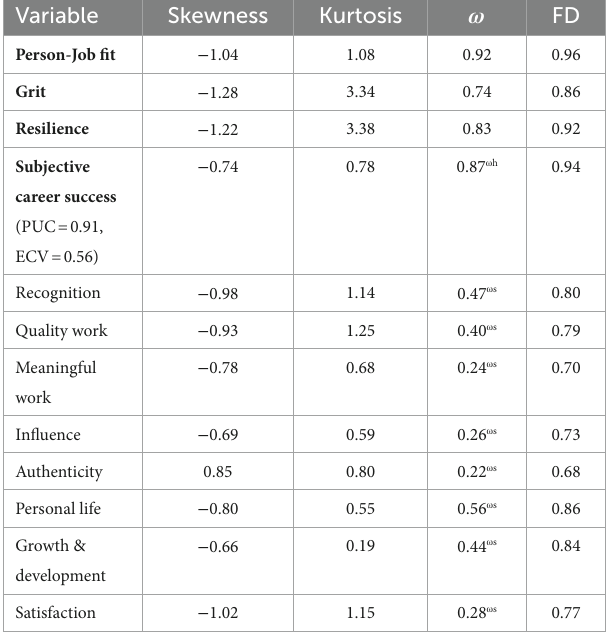
TABLE 3 Descriptive statistics, reliability and factor determinacy.